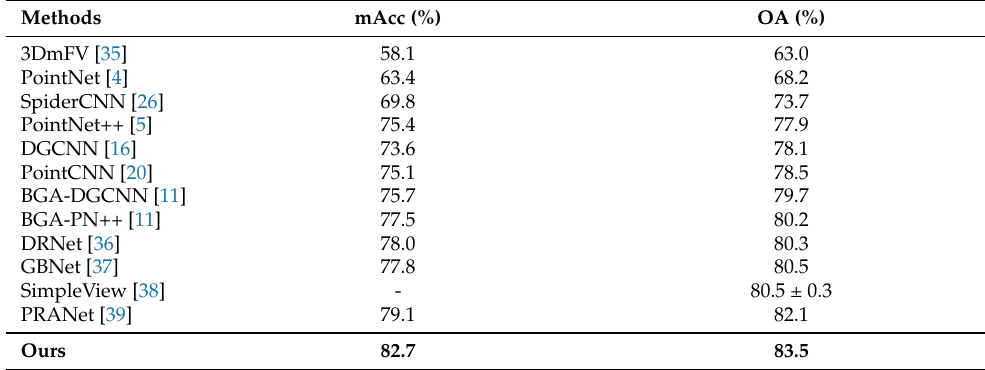
Table 2. Results on the ScanObjectNN object classification. The bolded text indicates the best results.